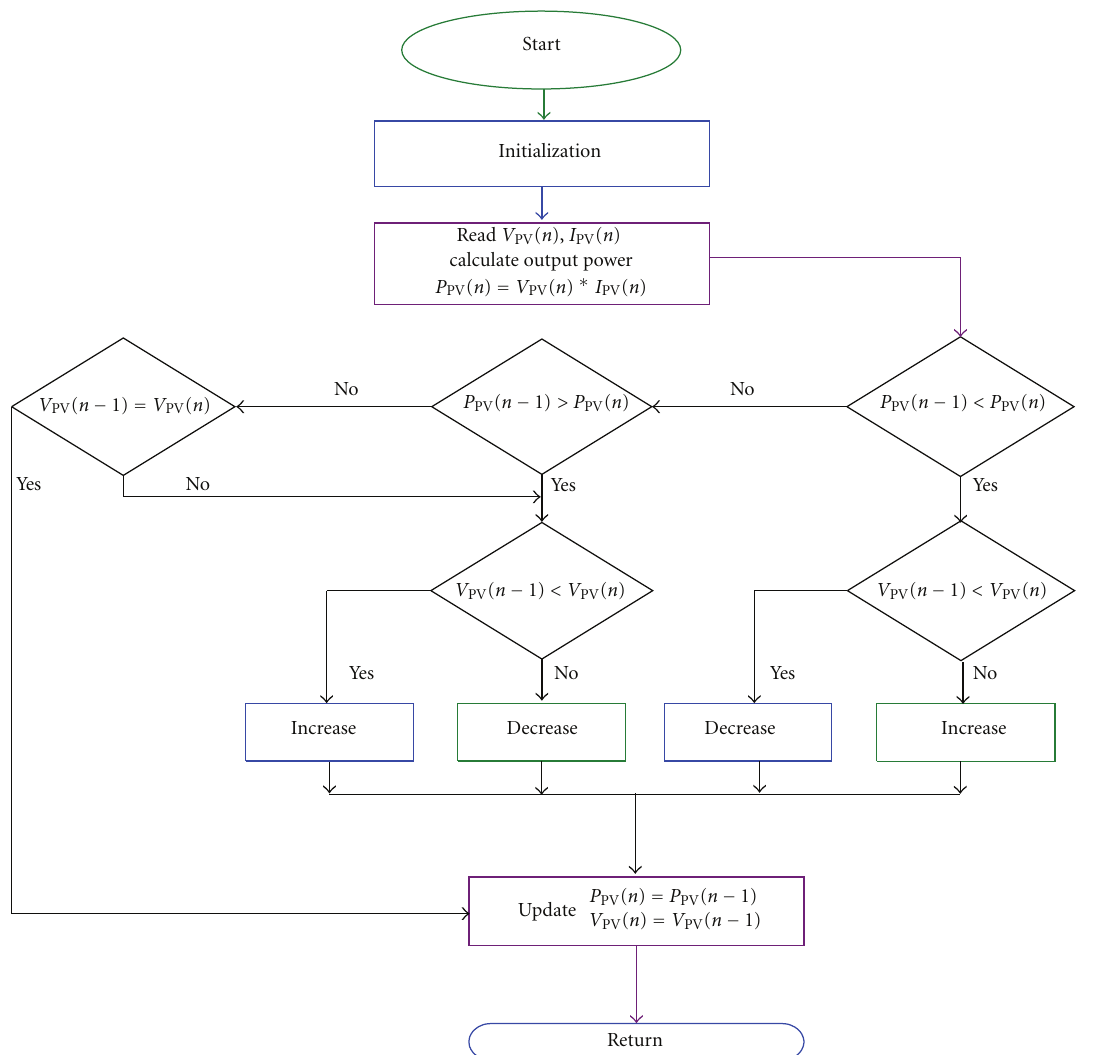
Figure 6: Flow chart of perturbation and observation method for MPPT